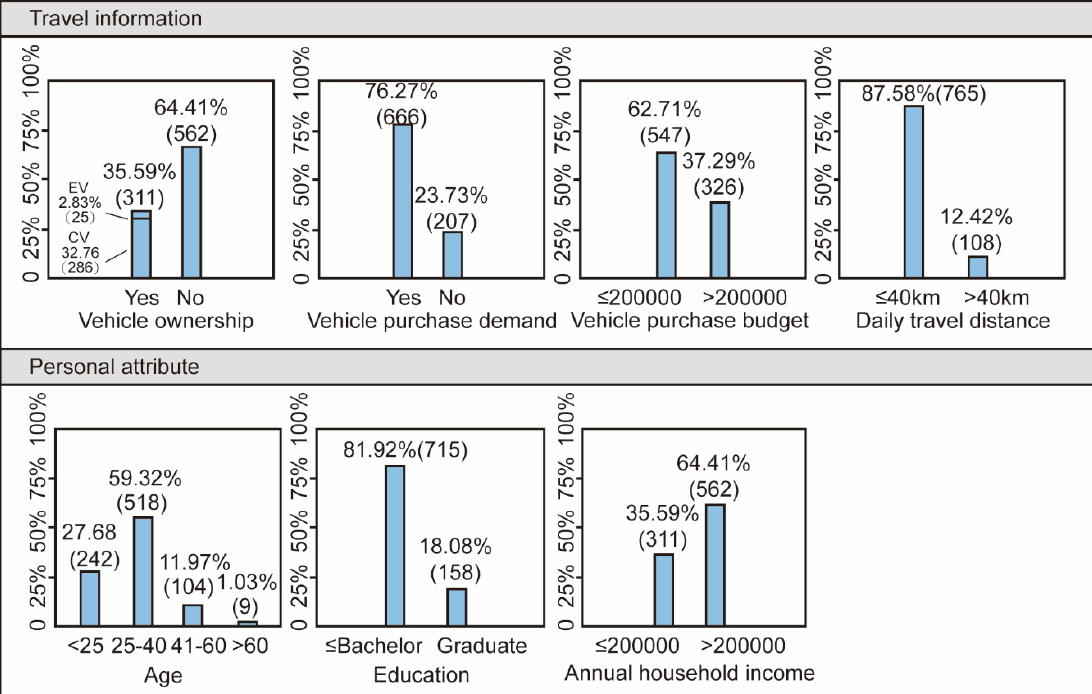
Figure 5. Choice result statistics for each scenario in the survey.